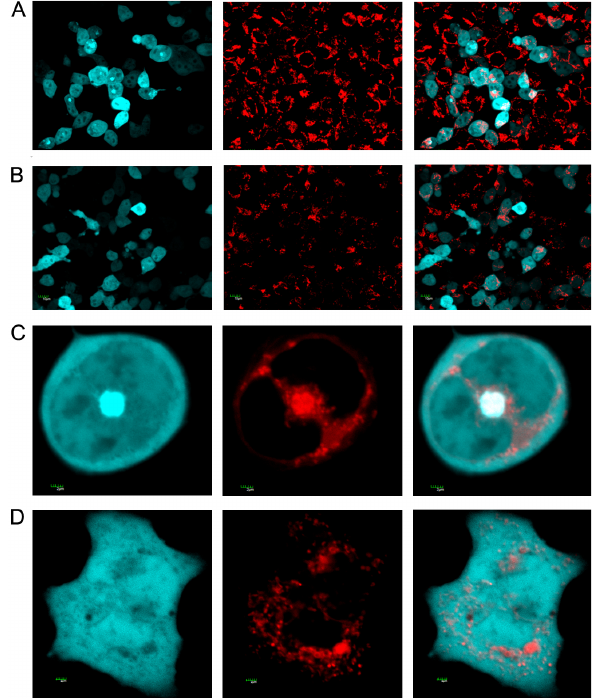
-CFP fusion proteins inside Figure 6. The mitochondrial morphology and location of A β 42 cells. The figures shown here are representative ones. HEK293T cells were cotranfected with A β -CFP plasmid and pSelexpress vacant vector ( A & C ) or pSelexpress- SelM -myc 42 SeO treatment. Left panels show cyan fluorescence from ( B & D ), under 0.5 μ mol/L Na 2 3 the CFP-fusion proteins; center panels are mitochondria images stained with Mito-Tracker Red CMXRos; right panels are images merging the left and the center. Scale bar in A & B : 10 µm and C & D : 2